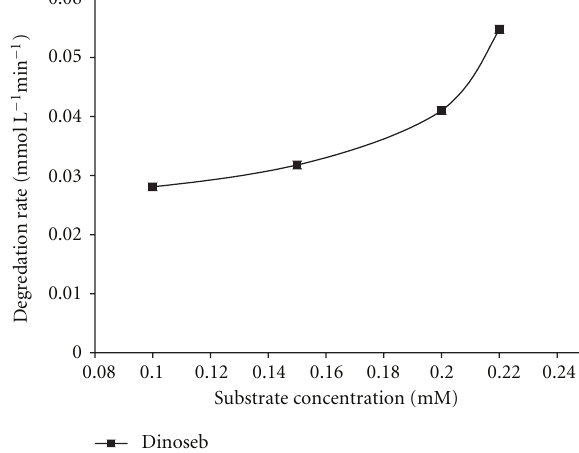
Figure 6: Influence of substrate concentration on the degradation rate of Dinoseb. Experimental conditions: substrate concentrations (0.10, 0.15, 0.20, and 0.22